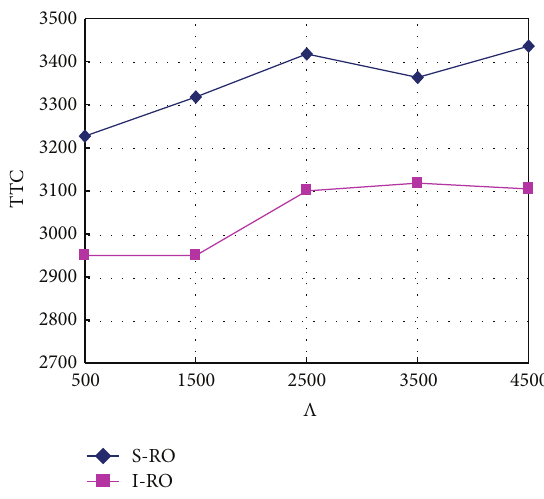
Figure 7: Variation in TTC for different Λ values.